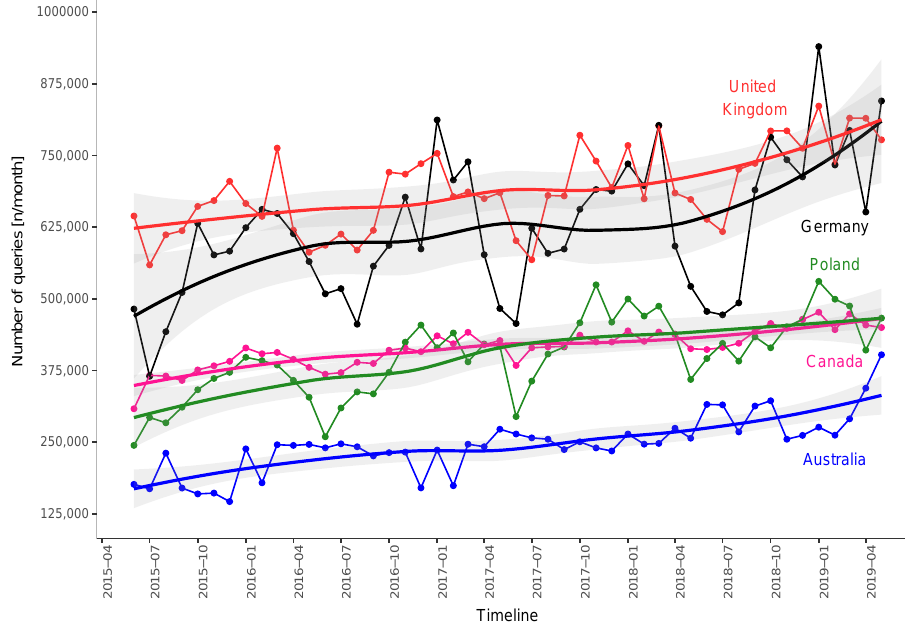
Figure 2. Number of heartburn-related Google queries from June 2015 to May 2019 in Australia, Canada, Germany, Poland, and The United Kingdom.